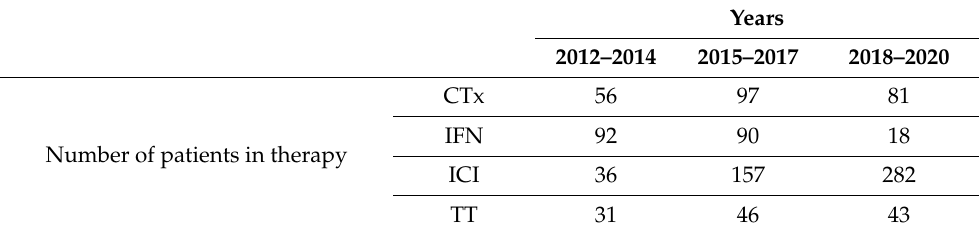
Table 2. Therapy types per patient documented over time during the observation period 2012 to 2020 for chemotherapy (CTx), immune checkpoint inhibitor therapy (ICI), targeted therapy (TT), and interferon therapy (IFN). Number of patients: n = 588 (including persons with locoregional